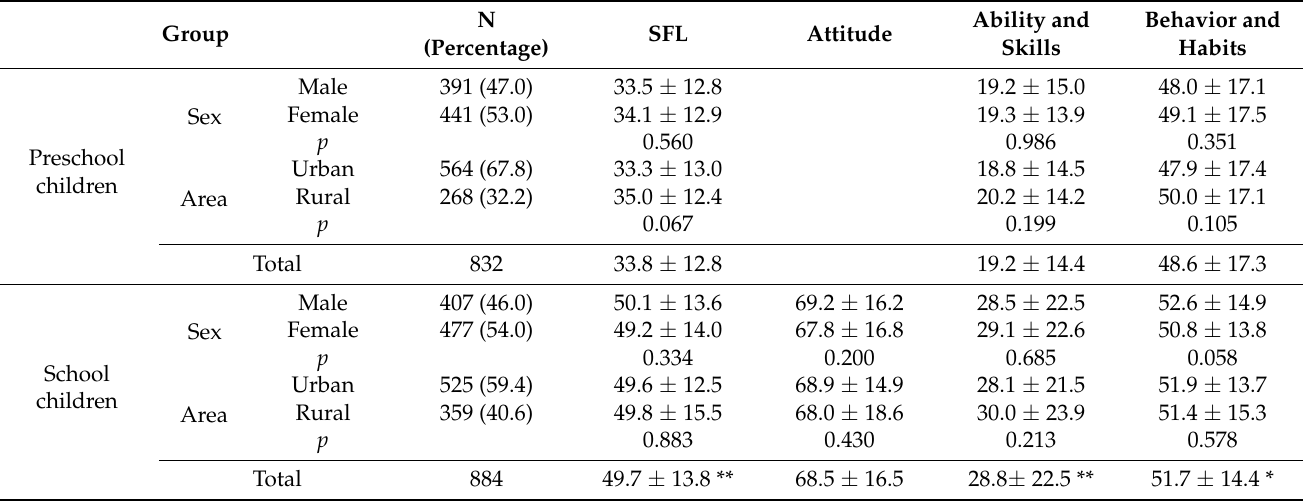
Descriptive statistics and means of scores on scientific fitness literacy (SFL) and its